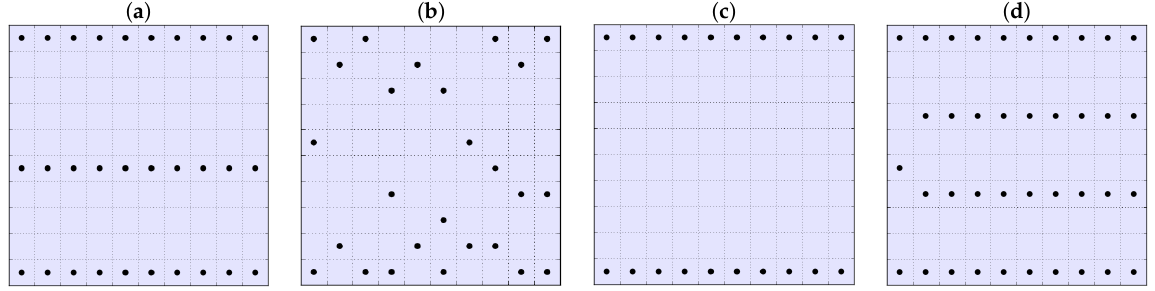
Figure 7. Reported optimal wind farm layouts for Case 1. ( a ) Grady et al. [7]. ( b ) Mosetti et al. [3]. ( c ) Emami et al. [9]. ( d ) Yang et al. [10].